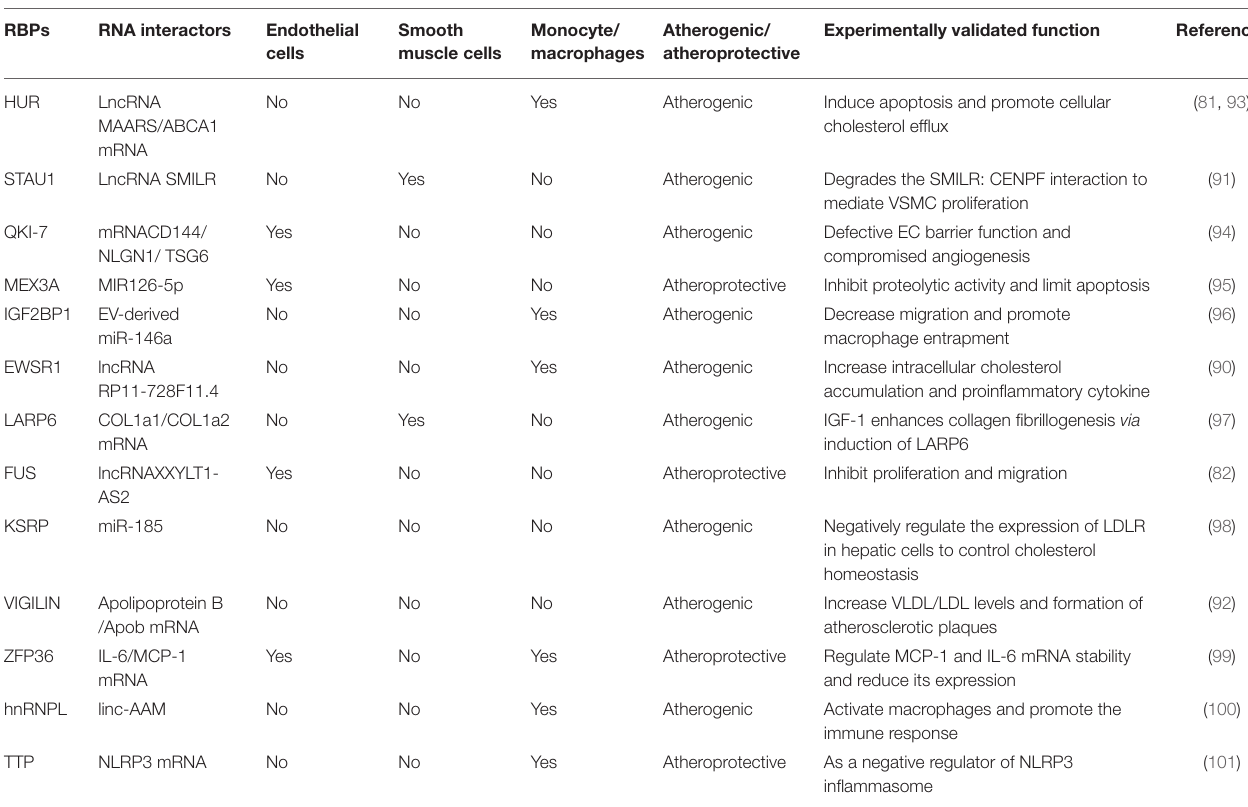
TABLE 2 | RNA-binding proteins in atherosclerosis-related research.